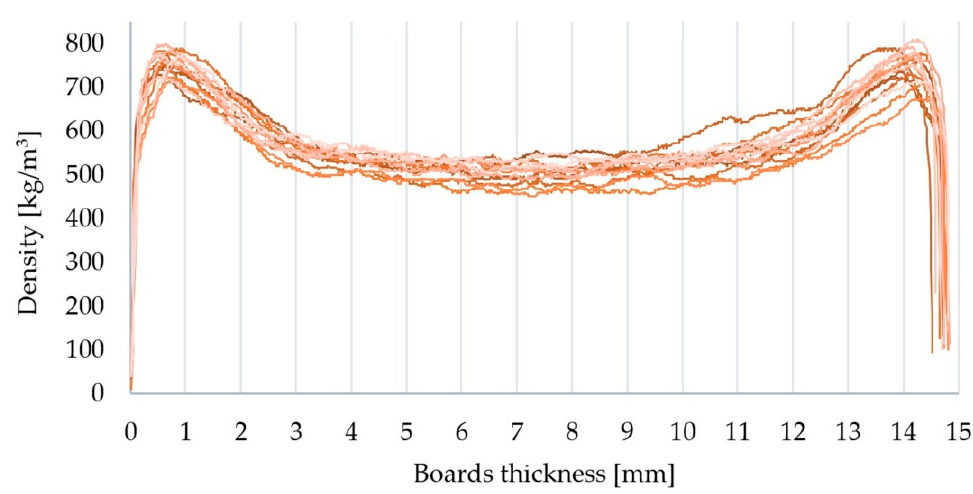
Figure 2. Density profiles of the particleboards